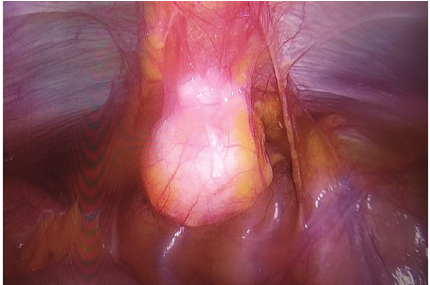
Figure 2: Laparoscopy image showing the mass in the median umbilical ligament superior to the bladder.